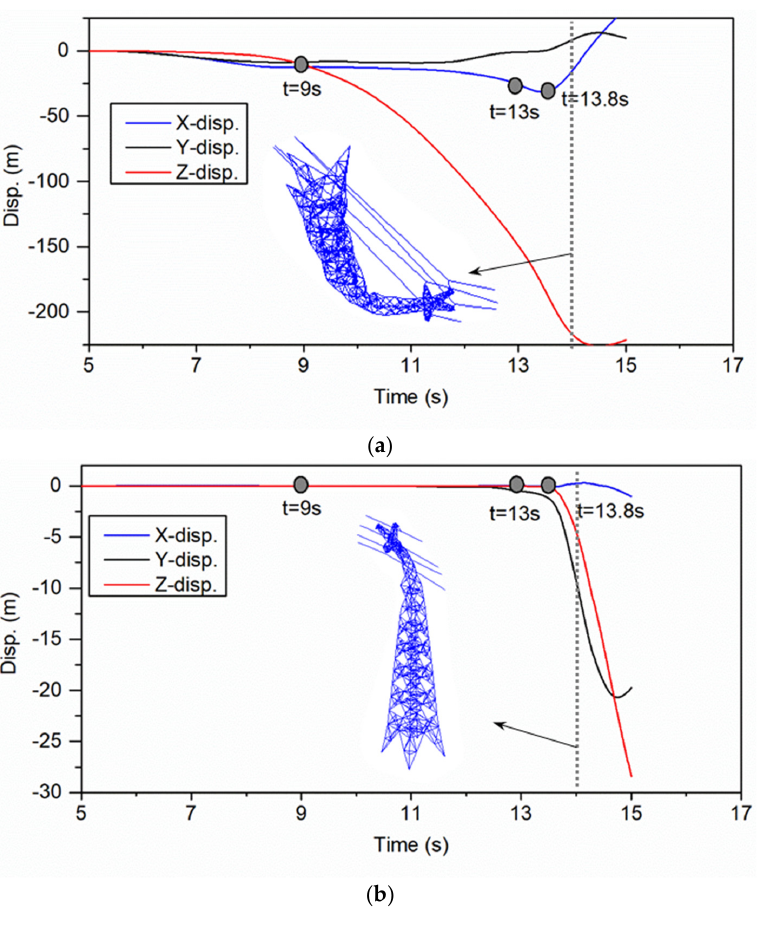
Energies 2022 , 15 , 7155 Figure 15. Displacement response at tower tops under Case 2. ( a ) Tower 2; ( b ) Tower 3.